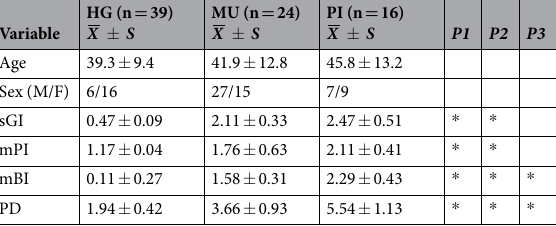
Table 1. Comparison of the general demographic characteristics and clinical parameters in different stages of peri-implant disease. P1 : HG vs. MU, P2 : HG vs. PI, P3 : MU vs. PI; * p -value ≤ 0.05. The demographic data were compared with a χ 2 - test, and the numerical data were compared with a one-way ANOVA and LSD multiple comparison.